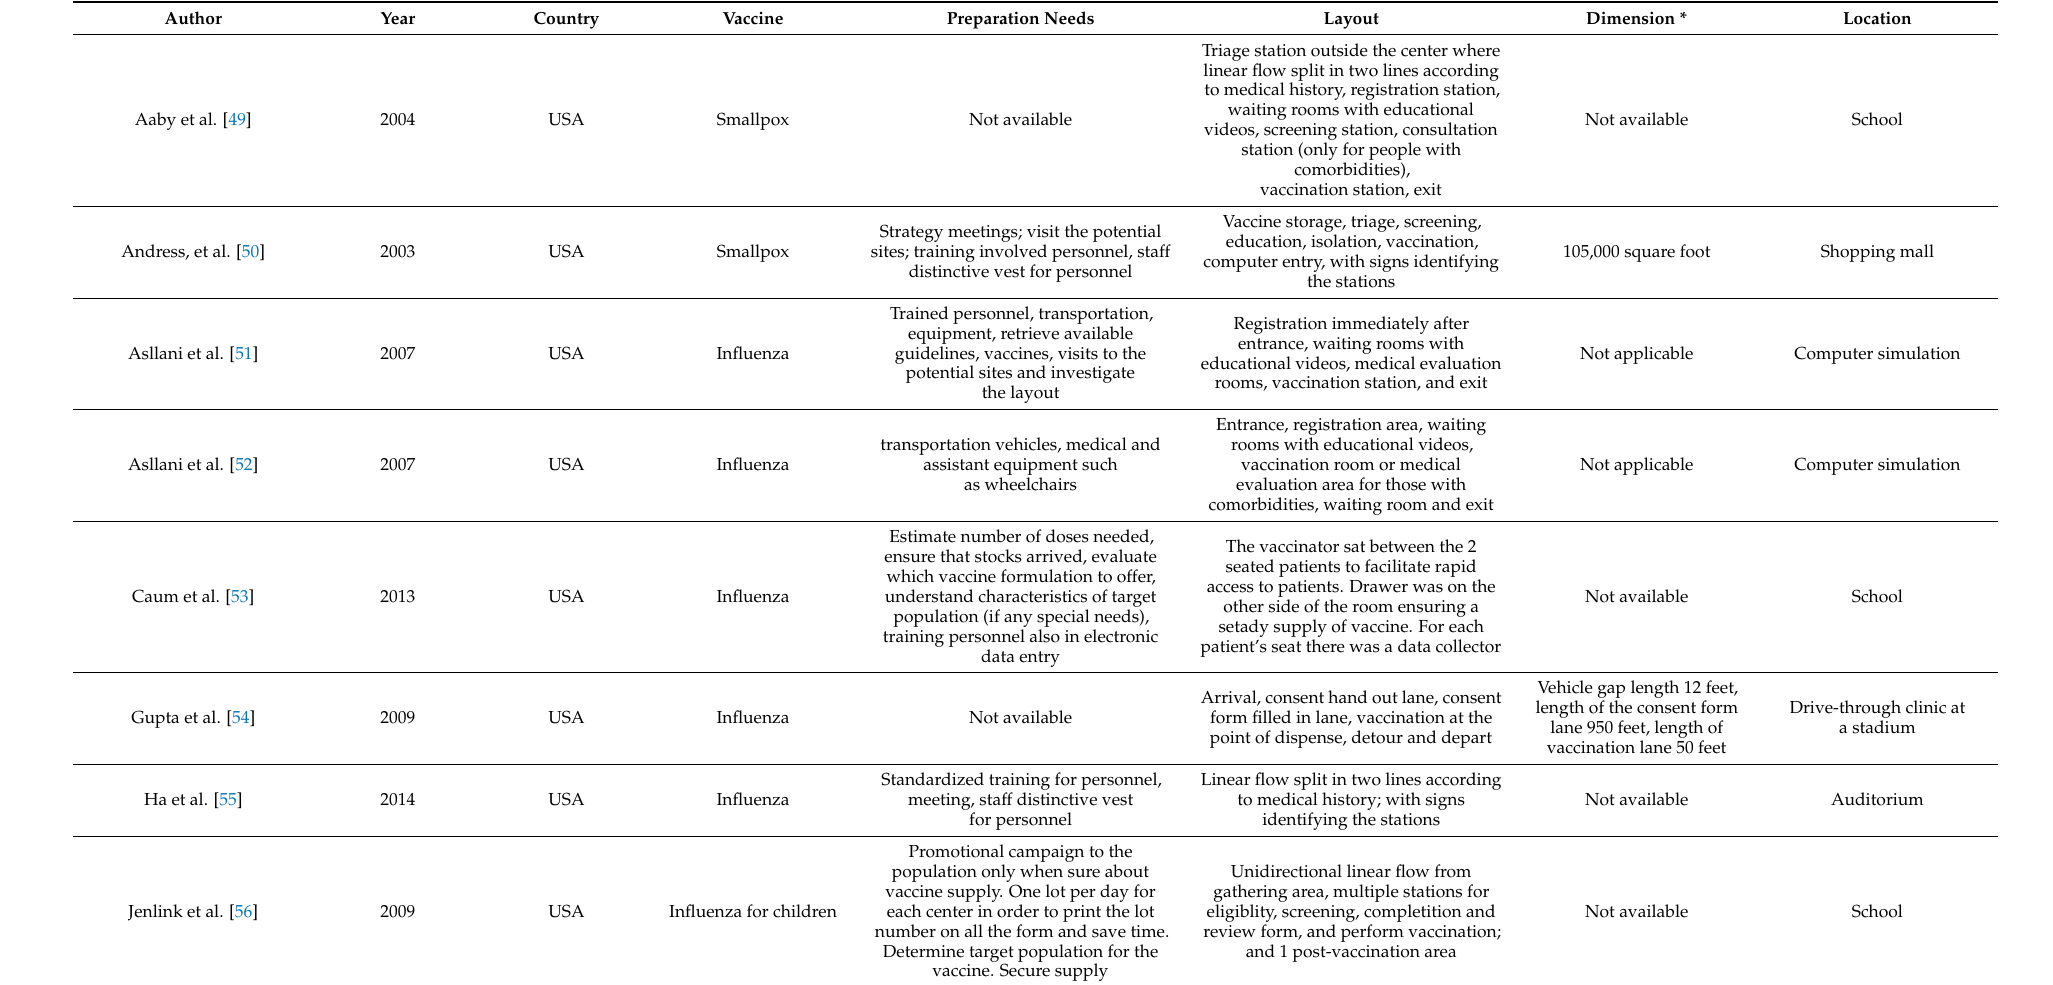
Table 1. General characteristics of the included